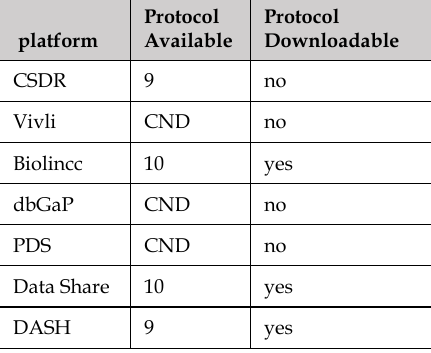
Table 5 Platform Protocol